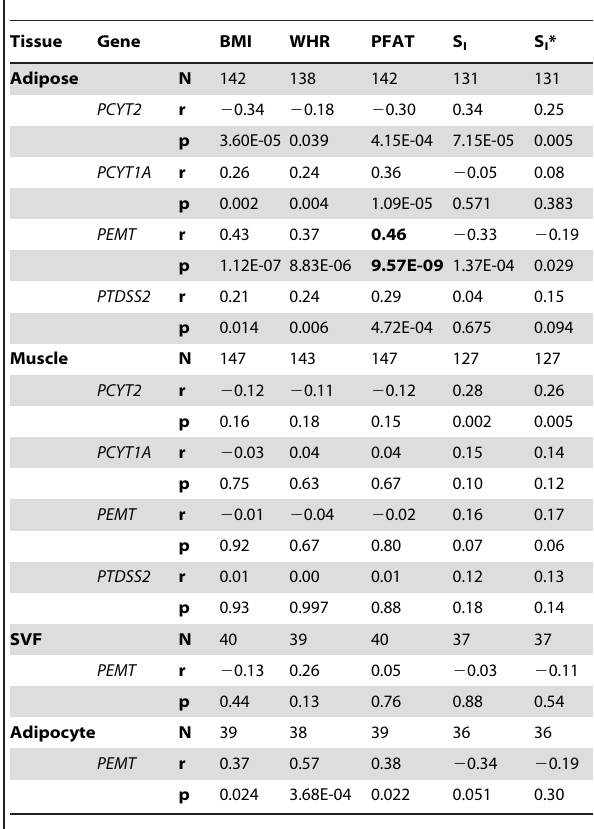
Table 2. Correlation of metabolic traits with expression of phospholipid biosynthesis genes in different tissues of non- diabetic